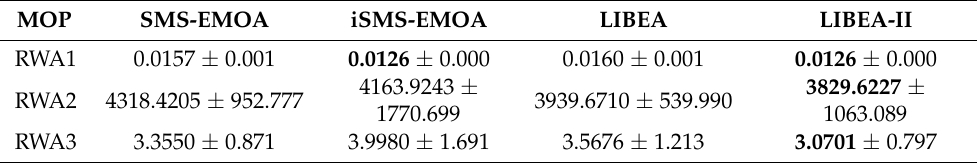
Table 6. Average IGD + values for the non-dominated solutions found by the IBEAs to each real- world application.